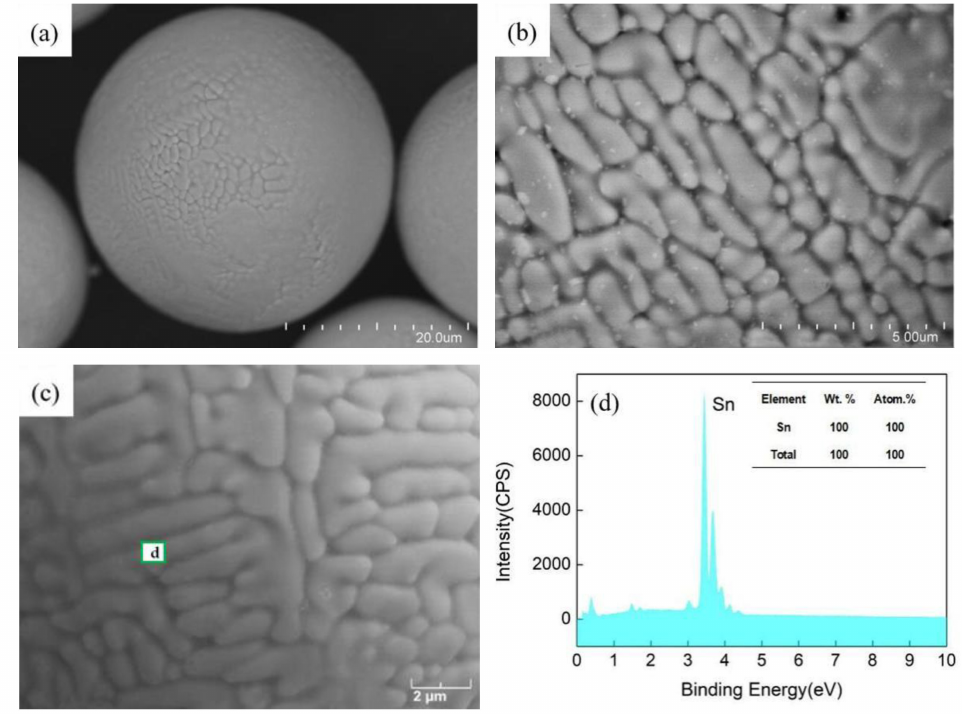
Figure 5. The SEM microstructure of the solder powder ( a – c ) and ( d ) the relative EDS results of Sn-rich phase as square d points in ( c ) on the solder powder ball